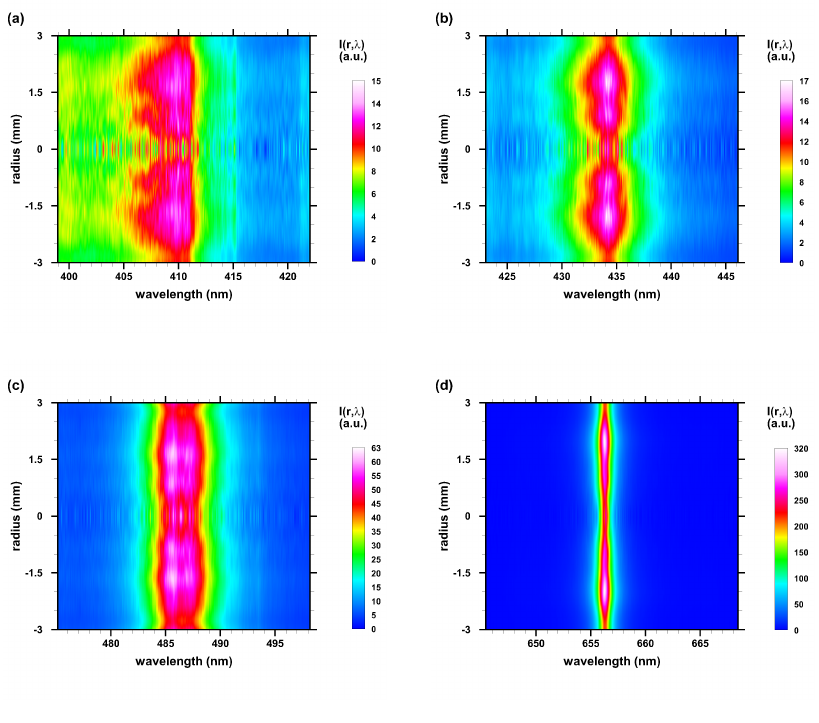
Figure 9. Abel-inverted Balmer-series hydrogen lines at 1.5- µ s time delay, 0.025- µ s gate. ( a ) H δ , ( b ) H γ , ( c ) H β , and ( d ) H α .